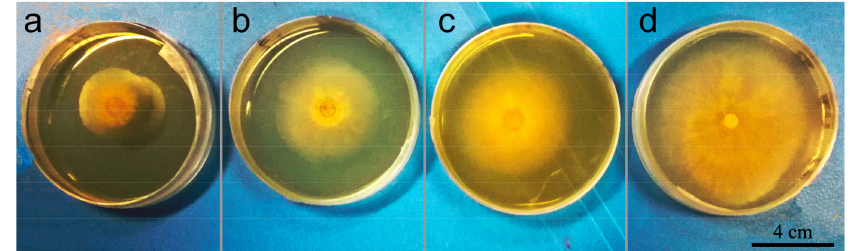
Figure 11. Antifungal efficacies of azoxystrobin microspheres against Colletotrichum higginsianum Sacc.